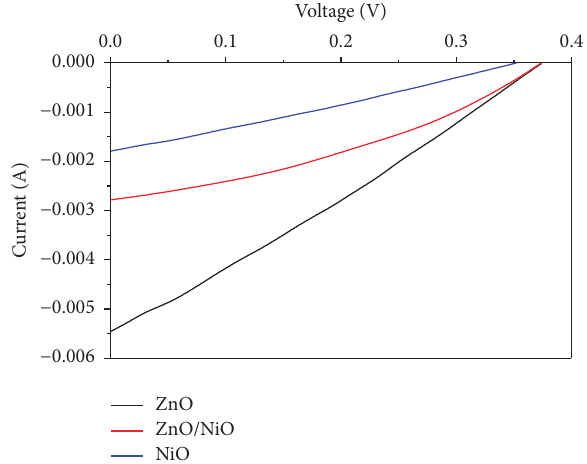
Figure 5: Current-voltage ( I - V ) characteristics of ZnO, NiO, and ZnO/NiO DSSCs.